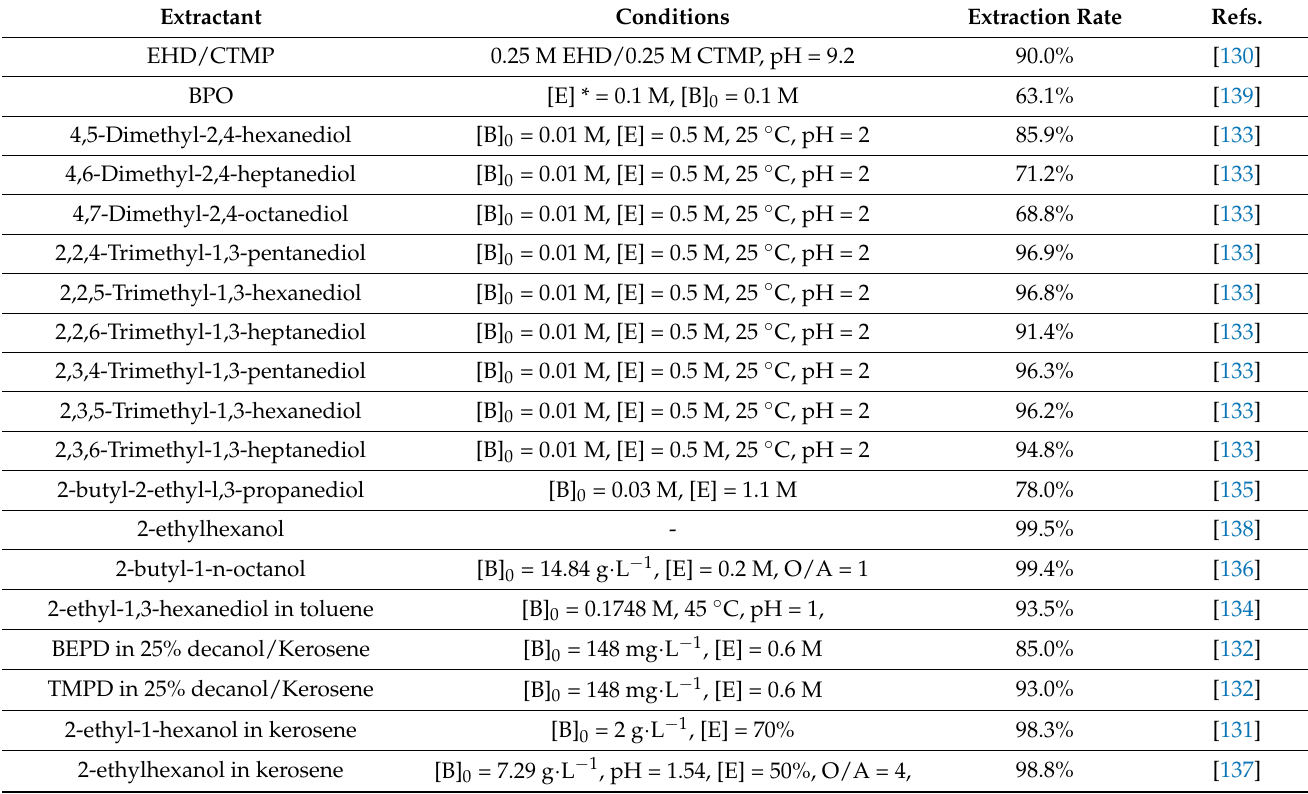
Table 17. Boron removal performances of different